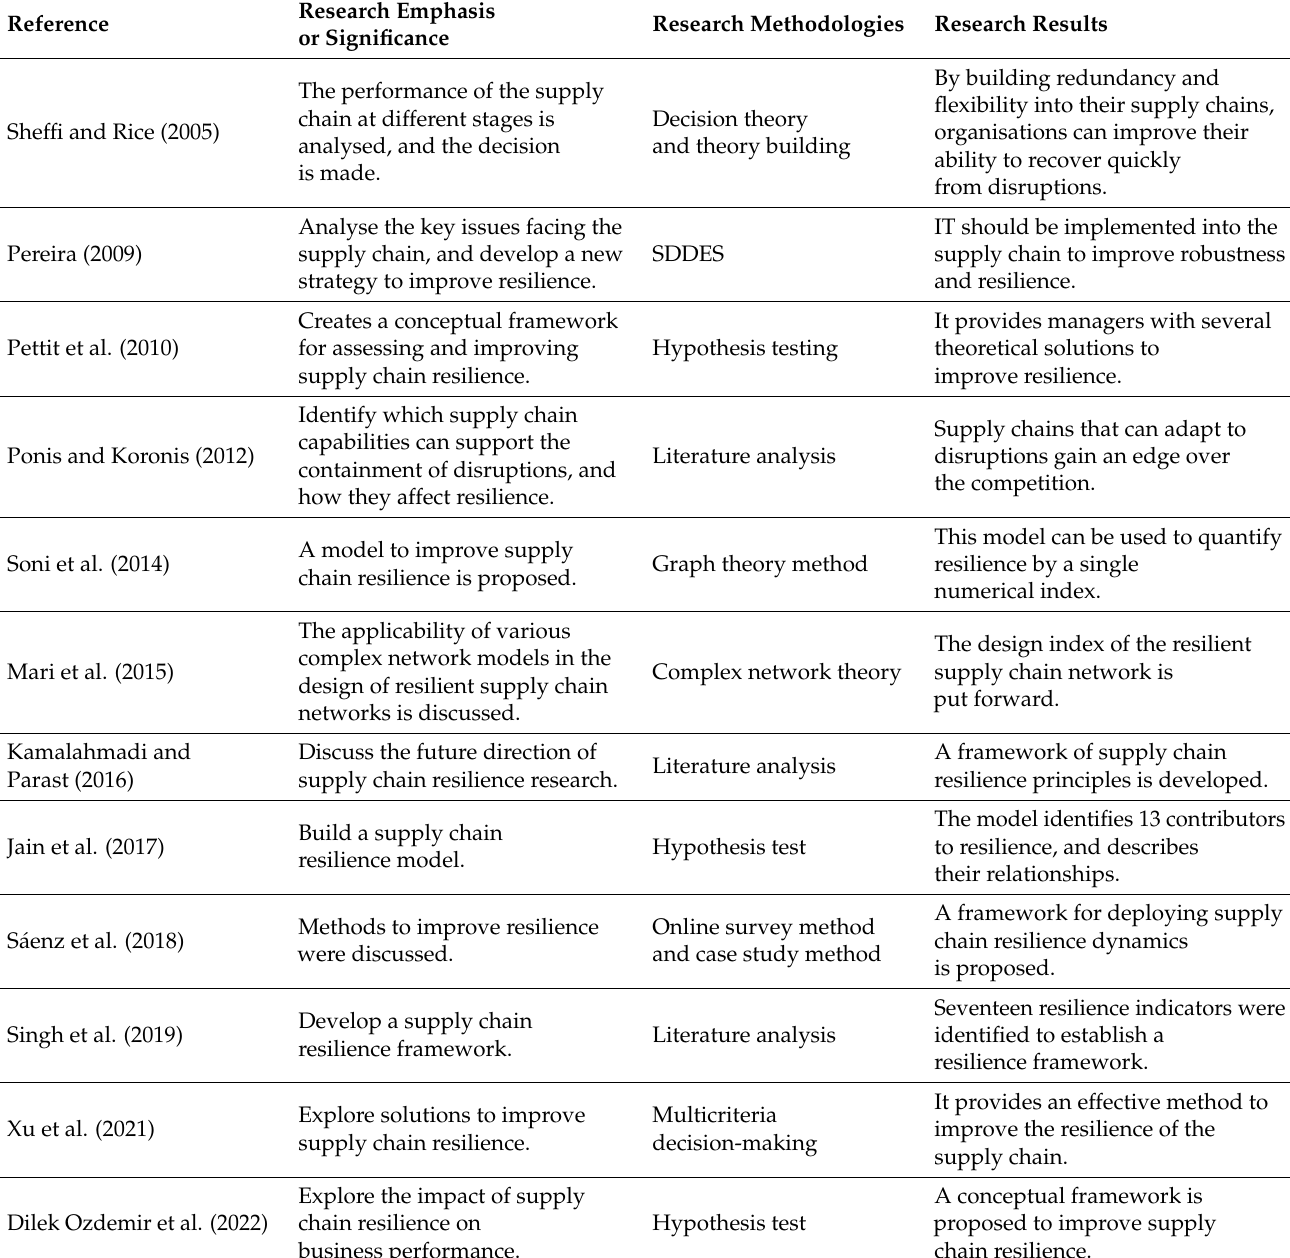
Table 2. Supply chain resilience summary